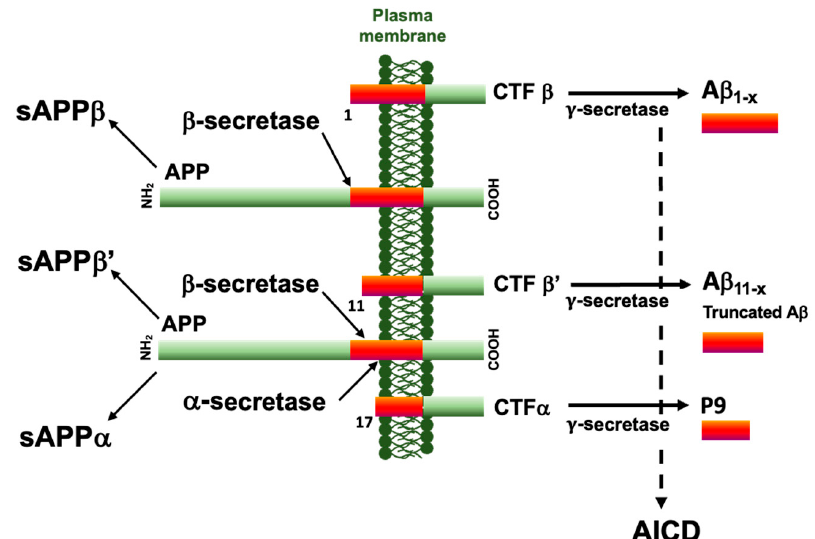
Figure 1. Summary scheme of the major APP processing pathways. The amyloid precursor protein is a type I transmembrane protein subject to sequential and alternative proteolytic cleavage. The β -secretase cleaves APP at the N-terminus of the A β peptide sequence to generate a soluble fragment sAPP β and a carboxy-terminal fragment CTF β . This β -secretase can alternatively cleave APP at position 11 and generate sAPP β ’ and CTF β ’. The α -secretase cleavage at position 17 precludes the